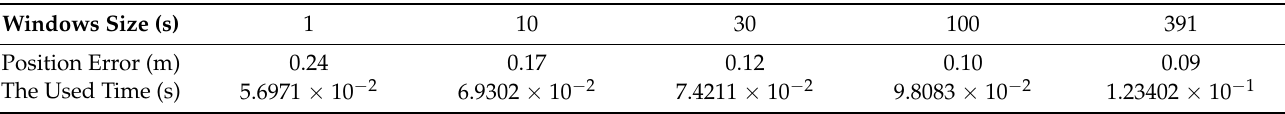
Figure 6. Variation in position error for different sliding window sizes, including 1, 10, 30, 100, and 391 s. Table 3. Comparison results of position accuracy and the time used for the single-step execution for different window sizes.